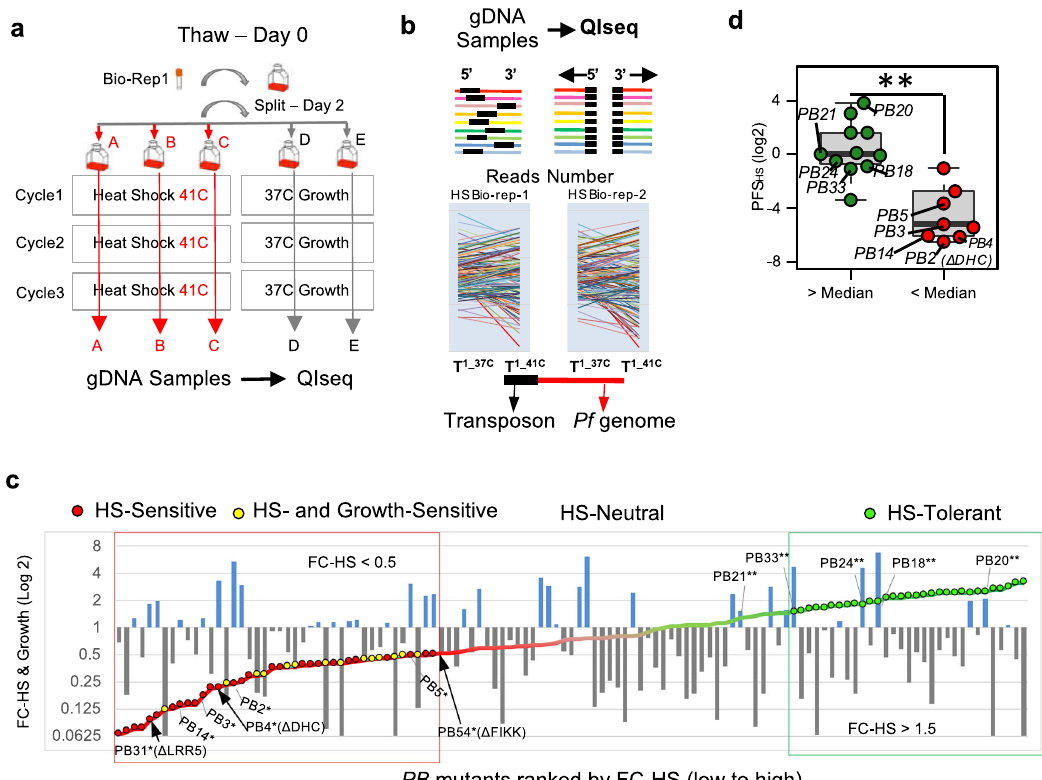
Fig. 1 Pooled screens of P. falciparum piggyBac mutants allow robust identi fi cation of heat-shock phenotypes. a Experimental design for pooled heat shock (HS) phenotypic screens. The pilot library of pB -mutant clones ( n = 128) was exposed to three rounds of temperature-cycling (41 °C for 8 h) to simulate malarial fever. A pilot-library control concurrently grown continuously at 37 °C established the inherent growth of each pB mutant. HS screens of the pilot library were conducted in biological duplicate and technical triplicate and were highly correlated, indicating high accuracy and reproducibility (see Supplementary Fig. 5a; “ Methods, Pooled-screen assay-design, HS-Screen ” section). b QIseq quanti fi es each pB -mutant in the pilot library from sequence- reads of the 5 ′ and 3 ′ ends of each pB insertion-site. Colored lines represent genes. Black boxes indicate transposon location (Supplementary Fig. 5b; “ Methods, QIseq ” section). c HS- and Growth-phenotypes of the pilot-library mutants. HS-phenotype of each mutant (displayed as line-graph) is superimposed on its corresponding Growth-phenotype (bar graph). Mutants are ordered by fold-change in response to HS (FC-HS) from Sensitive (red) to Tolerant (green). Mutants with inherently slower or faster growth under ideal conditions (FC-Growth) are shown in gray and blue, respectively. *Known HS-Sensitive and **HS-Tolerant pB-mutant clones served as benchmarks in the pilot-library HS-Screen for identifying sensitive/tolerant mutants 10 . See Supplementary Data File 1. d Phenotype comparison between mutants characterized in both individual HS-assays 10 and pooled HS-screening ( n = 20). Mutant clones without an observed phenotype in individual HS-assay as determined by above-average growth via fl ow cytometry (green) also had signi fi cantly higher Phenotypic Fitness Scores in response to HS (PFS HS ) in pooled screening, while mutant clones characterized as HS-Sensitive in individual assays (red) also had signi fi cantly lower PFS HS in pooled screening (** p -value < 0.01, two-tailed Wilcoxon test). Boxplots are drawn to present an interquartile range of values (IQR). Lower bound of each box = 1st quartile, middle line = median, upper bound = 3rd quartile, and whiskers extend to at most 1.5×